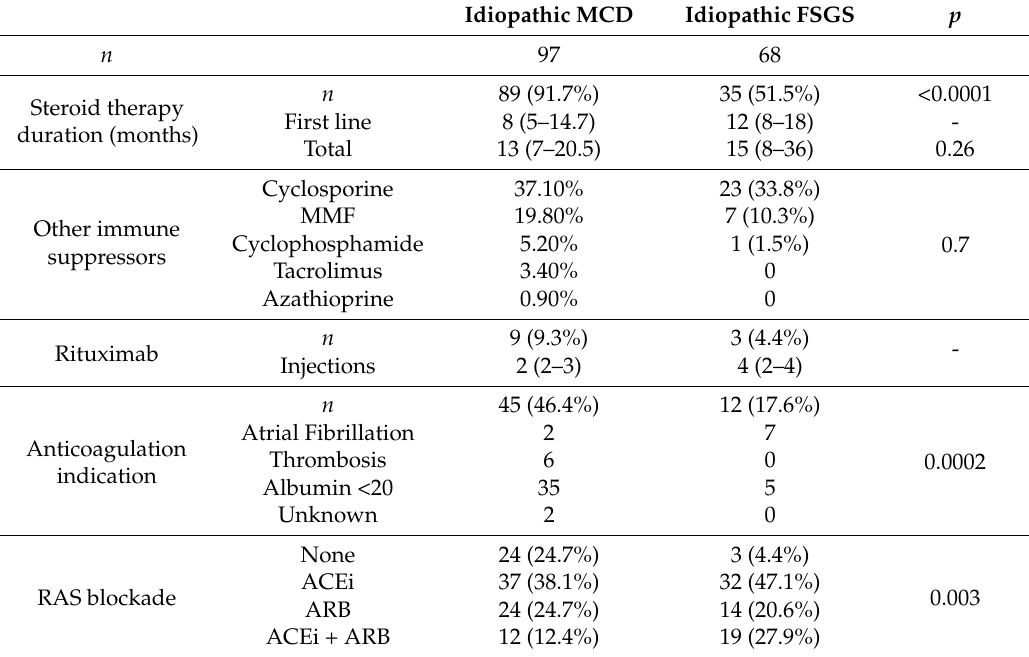
Table 2. Therapeutic strategies of MCD and FSGS